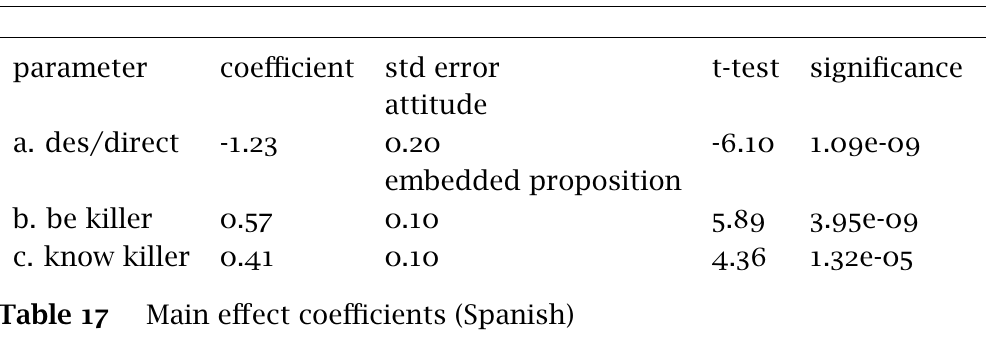
Main effect coefficients (Spanish)